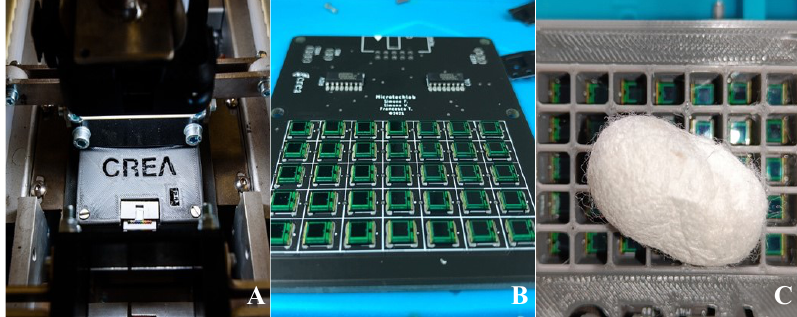
Figure 5. Light sensor in its case mounted on the prototype ( A ), assembled PCB of the light sensor ( B ) and positioning example of the cocoon over the matrix of light sensors ( C ).